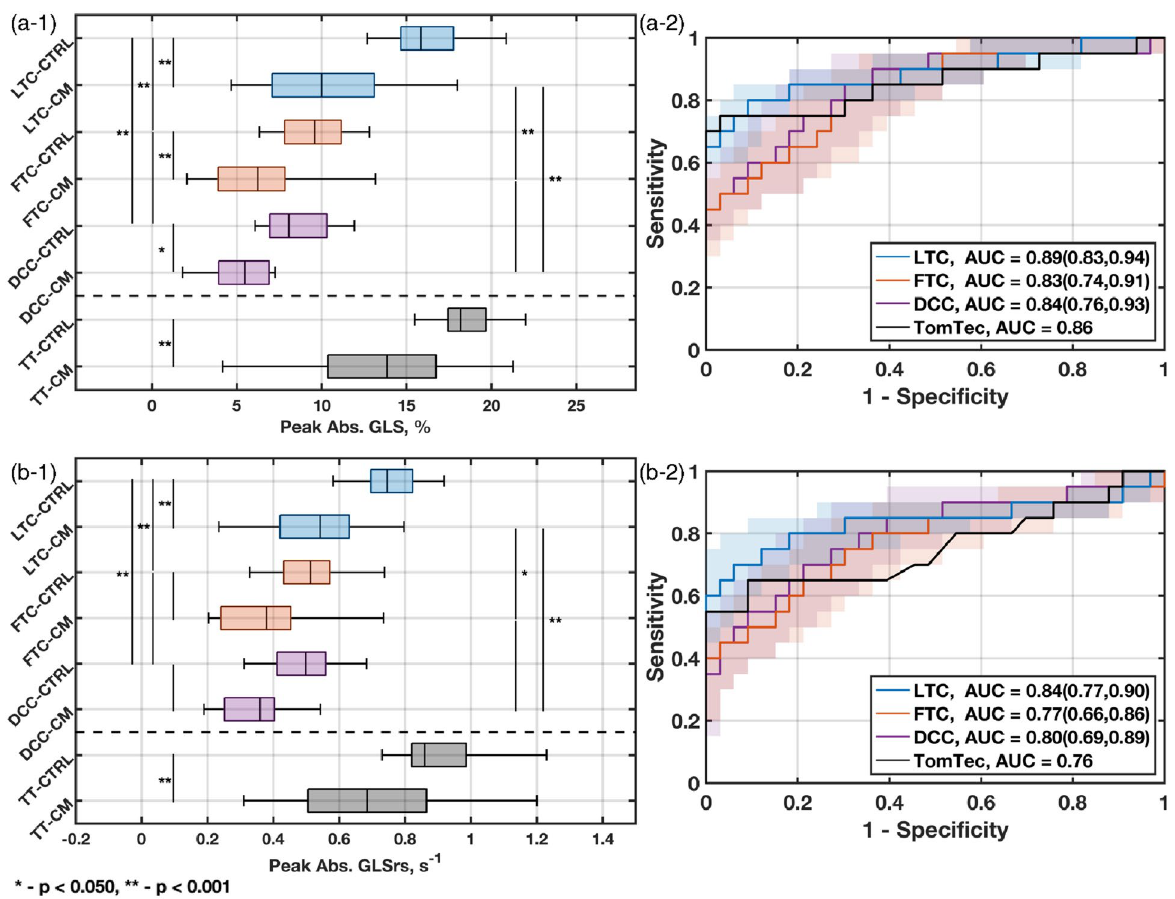
Figure 3. Distribution of measurements and significance tests for each GLS measurement method on observing ( a-1 ) peak absolute GLS (GLS P ) and ( b-1 ) peak absolute systolic GLSr (GLSrs). (2) Receiver operating characteristic (ROC) curves displaying the ability for the LTC method estimated parameters to distinguish between normal and abnormal cardiac disease states based on ( a-2 ) GLS P and ( b-2 ) GLSrs. The analysis was performed on a set of control subjects (CTRL) and subjects with cardiomyopathies (CM). The LTC method was compared with the conventional STE methods, FTC and DCC, as well as with the commercially available TomTec software. The bounded regions about the ROC curve provide the 95% confidence interval over which sensitivity and specificity are measured, contingent on the beat records and scans analyzed within